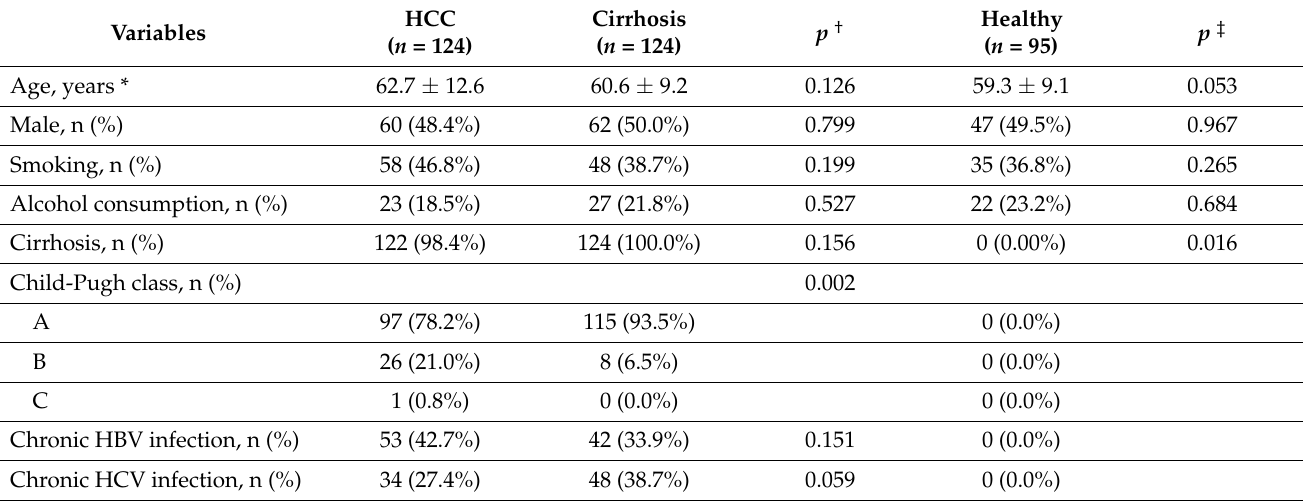
Table 1. Baseline characteristics of the study